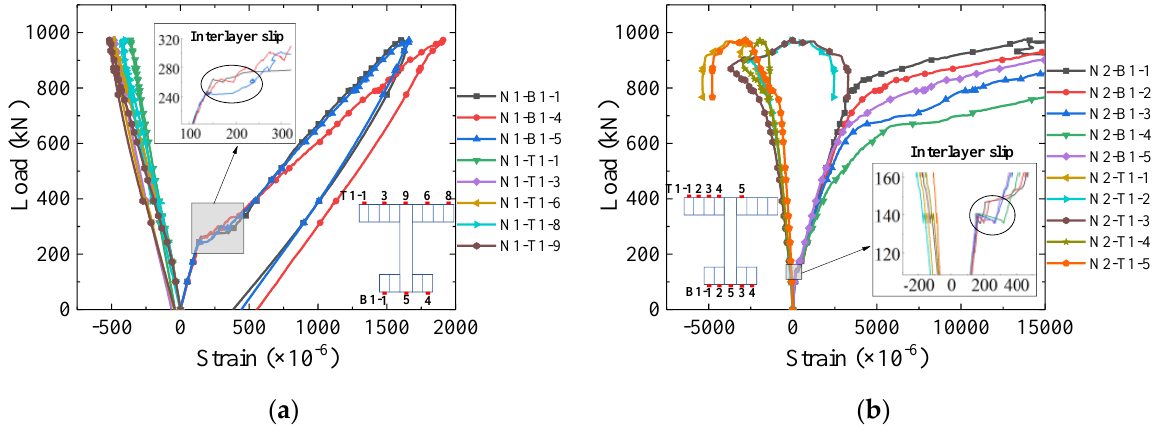
Figure 10. Load – strain curves of the steel flange. ( a ) Quarter-span; ( b ) mid-span. The load–strain curves of the steel web and the longitudinal reinforcing bars at mid- span are shown in Figure 11 (some strain gauges on reinforcing bars were damaged during construction and are not shown). Strain gauges N2-W-1, N2-R2-1/2, N2-W-2 and N2-R3- 1/2 share the same height as the section. Regarding the strain gauge N2-W-1, N2-R2-1/2, N2-W-2 and N2-R3-2, it is evident that the strain of the steel web and reinforcing bars at the same section height is identical during the elastic stage; however, at 200 kN, there is an interlayer slip observed in the nethermost reinforcing bar. The last two rows of reinforcing bars reached yielding at the later loading stage, while the rest remained elastic.